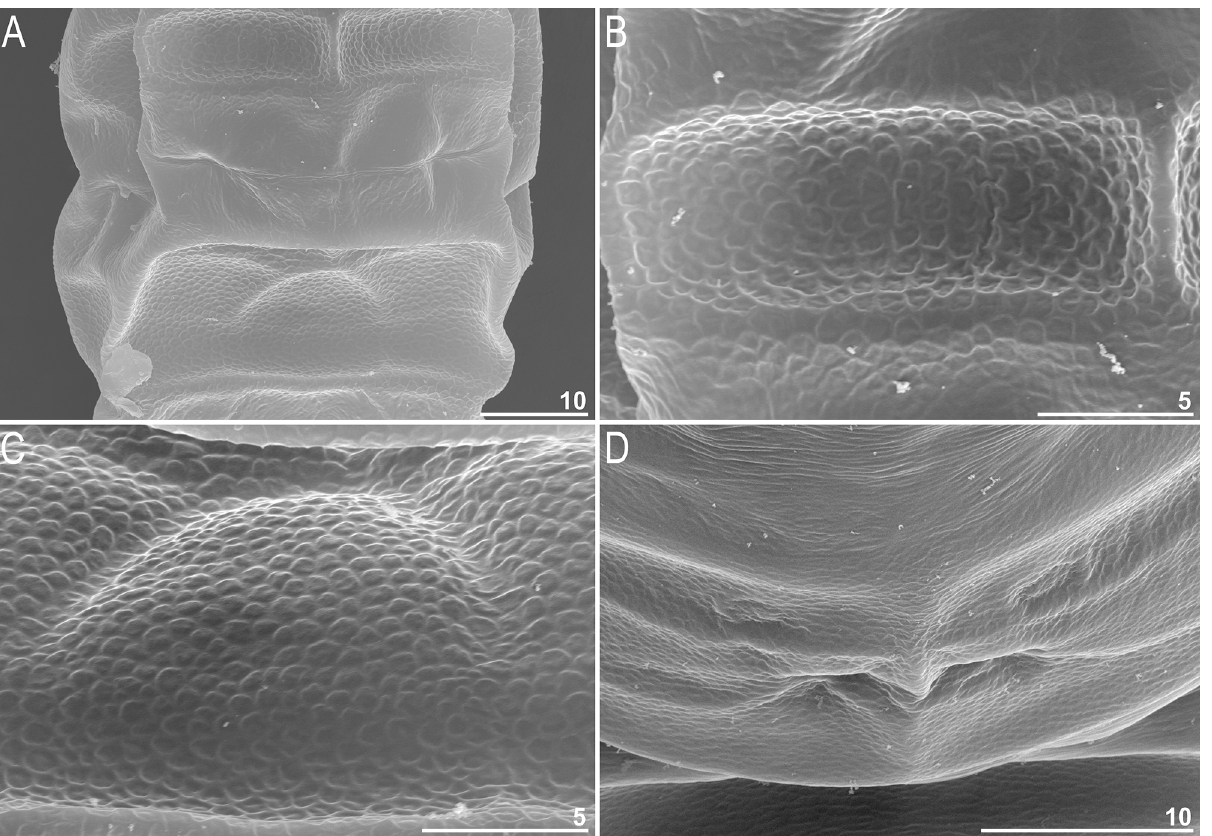
Figure 3. Dorsal cuticle sculpturing of Milnesium decorum sp. nov. seen in SEM: ( A ) polygonal reticulation and pseudoplates of row VII and VIII (hatchling or juvenile); ( B ) close-up on the on row VII (hatchling or juvenile); ( C ) close-up on row VIII (hatchling or juvenile); ( D ) close-up on row VIII of (adult specimen). Please note that the sculpture is formed by a polygonal reticulum with thin walls and shallow dimples and pseudoplates are concave, but because of optical illusion pseudoplates may seem convex and dimples may appear as polygonal granules [especially in ( B and C )]. All scale bars in